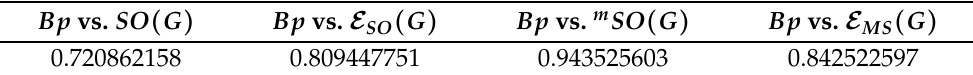
Table 5. Correlation of the boiling points (Bp) with each of the following topological indices for the case of all chemical graphs of the order of at most 7: Sombor index, Sombor energy, modified Sombor index, and modified Sombor